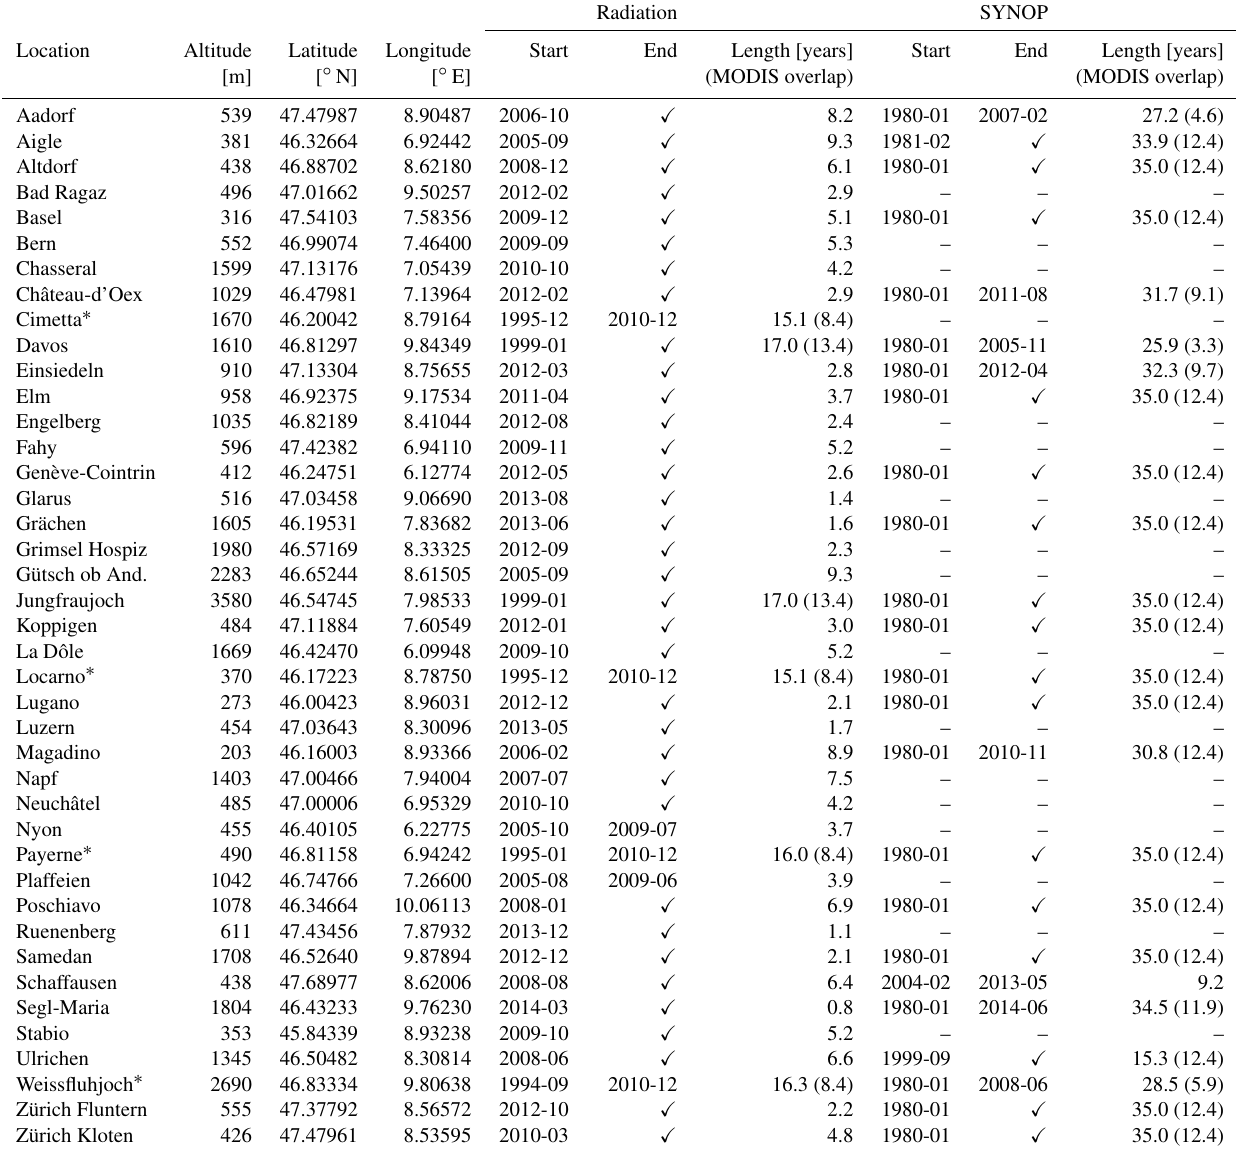
Table A1. Location and data coverage of the 41 ground-based stations used in this study. The length of overlap with MODIS is not specified when the whole record overlaps temporally with the MODIS time range (1 August 2002 to 31 December